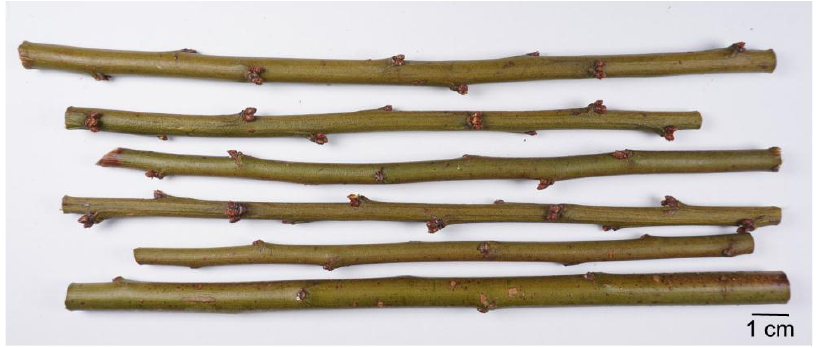
Figure 7. The branches (less than a year old) of Prunus mume (Siebold) Siebold & Zucc.